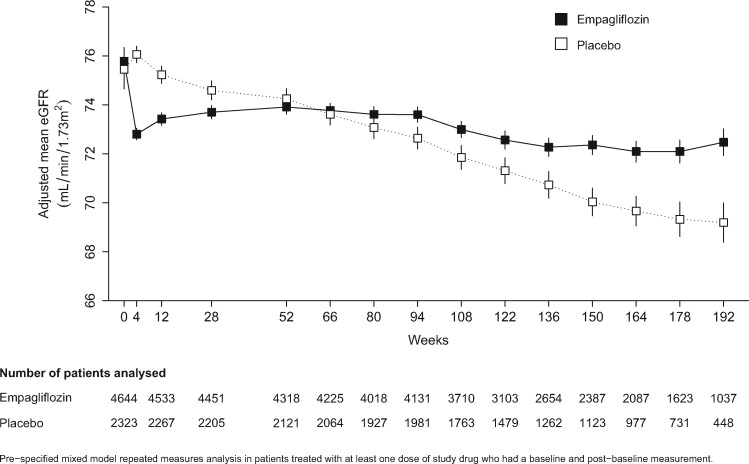
Effect of allocation to empagliflozin versus placebo on Chronic Kidney Disease Epidemiology Collaboration eGFR.